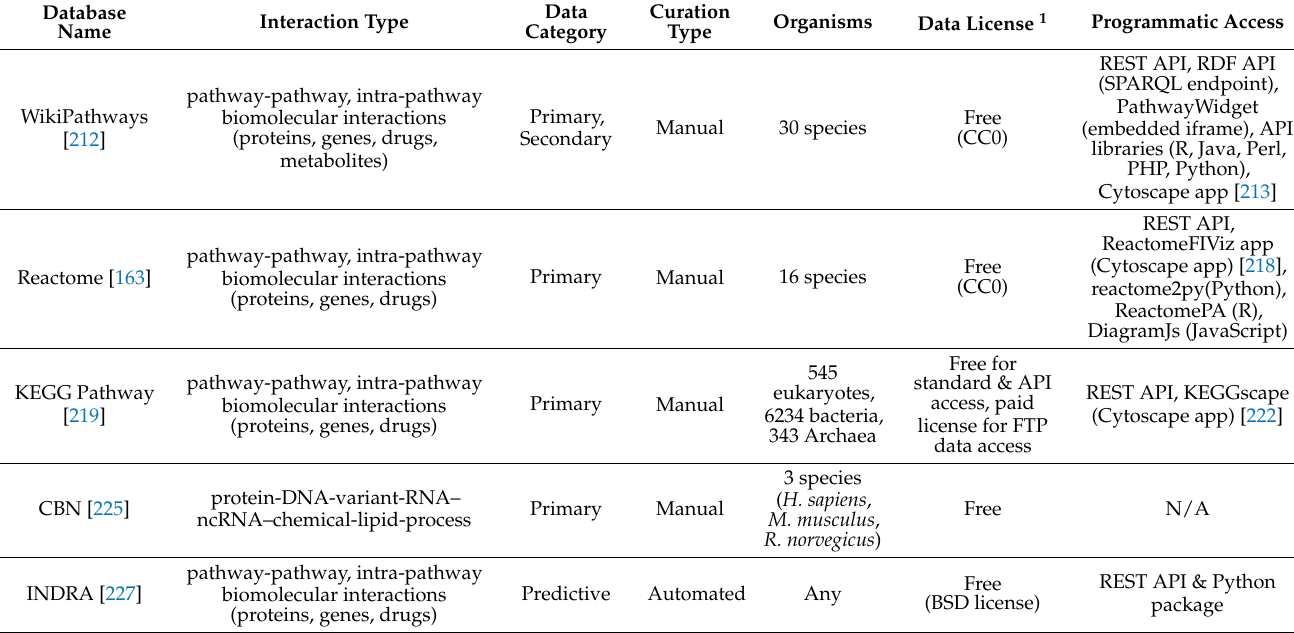
Table 7. Signaling and metabolic pathway interaction